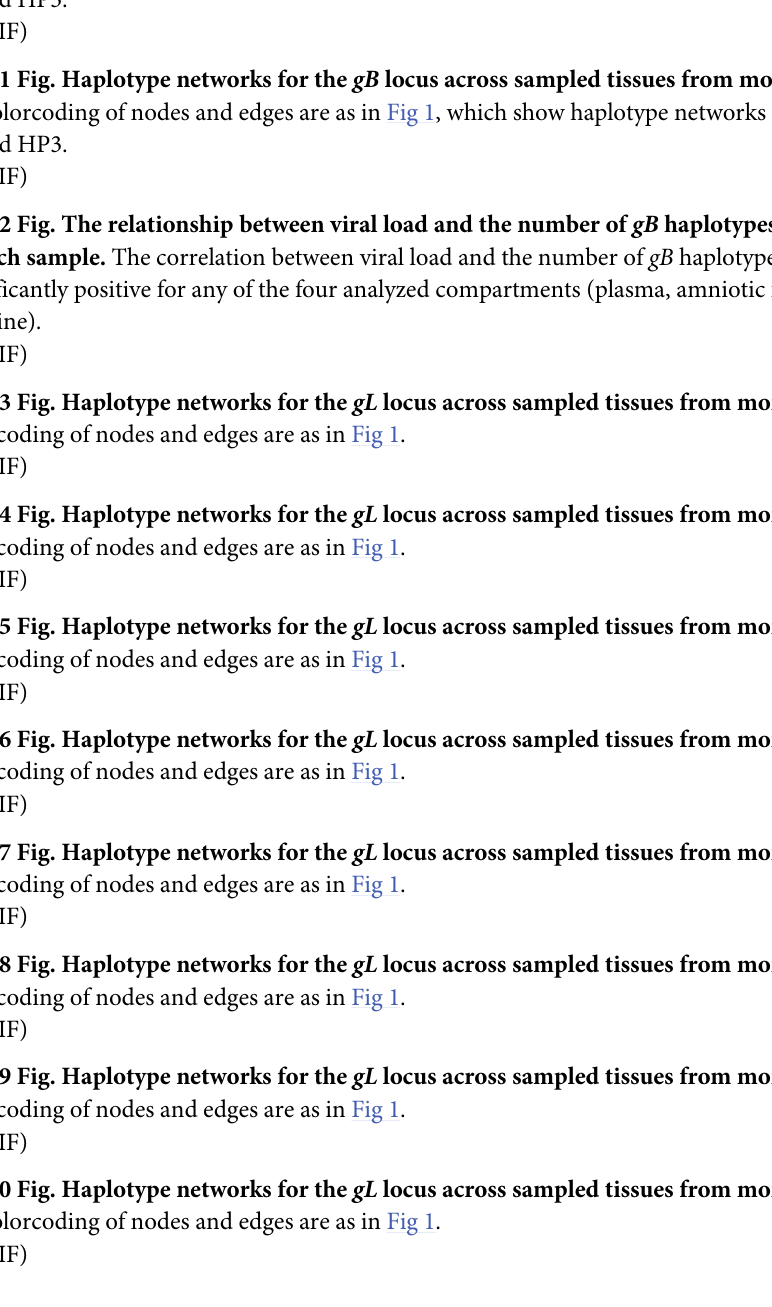
S9 Fig. Haplotype networks for the gB locus across sampled tissues from monkey S3. Col- orcoding of nodes and edges are as in Fig 1, which show haplotype networks for C4, S2, and HP3. (TIF) S10 Fig. Haplotype networks for the gB locus across sampled tissues from monkey HP1. Colorcoding of nodes and edges are as in Fig 1, which show haplotype networks for C4, S2, and HP3. (TIF) S11 Fig. Haplotype networks for the gB locus across sampled tissues from monkey HP2. Colorcoding of nodes and edges are as in Fig 1, which show haplotype networks for C4, S2, and HP3. (TIF) S12 Fig. The relationship between viral load and the number of gB haplotypes found in each sample. The correlation between viral load and the number of gB haplotypes was not sig- nificantly positive for any of the four analyzed compartments (plasma, amniotic fluid, saliva, urine). S13 Fig. Haplotype networks for the gL locus across sampled tissues from monkey C1. Col- orcoding of nodes and edges are as in Fig 1. S14 Fig. Haplotype networks for the gL locus across sampled tissues from monkey C3. Col- orcoding of nodes and edges are as in Fig 1. S15 Fig. Haplotype networks for the gL locus across sampled tissues from monkey C4. Col- orcoding of nodes and edges are as in Fig 1. S16 Fig. Haplotype networks for the gL locus across sampled tissues from monkey C5. Col- orcoding of nodes and edges are as in Fig 1. S17 Fig. Haplotype networks for the gL locus across sampled tissues from monkey S1. Col- orcoding of nodes and edges are as in Fig 1. S18 Fig. Haplotype networks for the gL locus across sampled tissues from monkey S2. Col- orcoding of nodes and edges are as in Fig 1. S19 Fig. Haplotype networks for the gL locus across sampled tissues from monkey S3. Col- orcoding of nodes and edges are as in Fig 1. S20 Fig. Haplotype networks for the gL locus across sampled tissues from monkey HP1. Colorcoding of nodes and edges are as in Fig